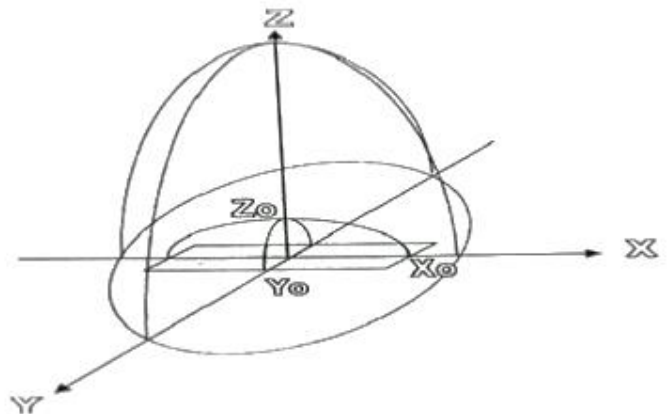
Figure 1: Scheme of the ellipsoid assumed for the vacuum plasma expansion. Grey rectangle represents the laser spot